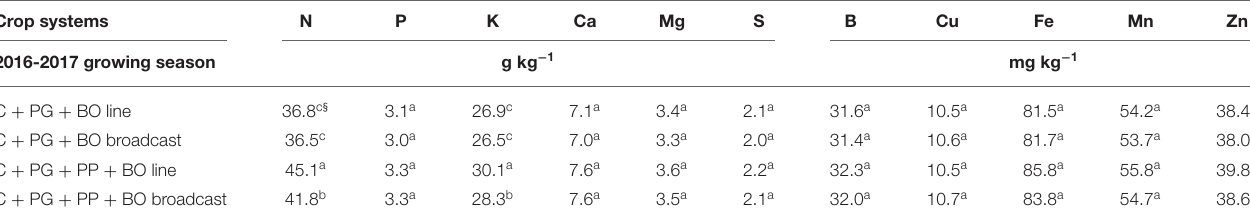
TABLE 10 | Soybean leaf nutrient concentrations at the R2 growth stage intercropped with guinea grass to silage in the fourth growing season in succession with corn to silage intercropped with palisade grass (C + PG) and with palisade grass and pigeon pea (C + PG + PP) with black oat (BO) oversown in lines and broadcast in the first three growing